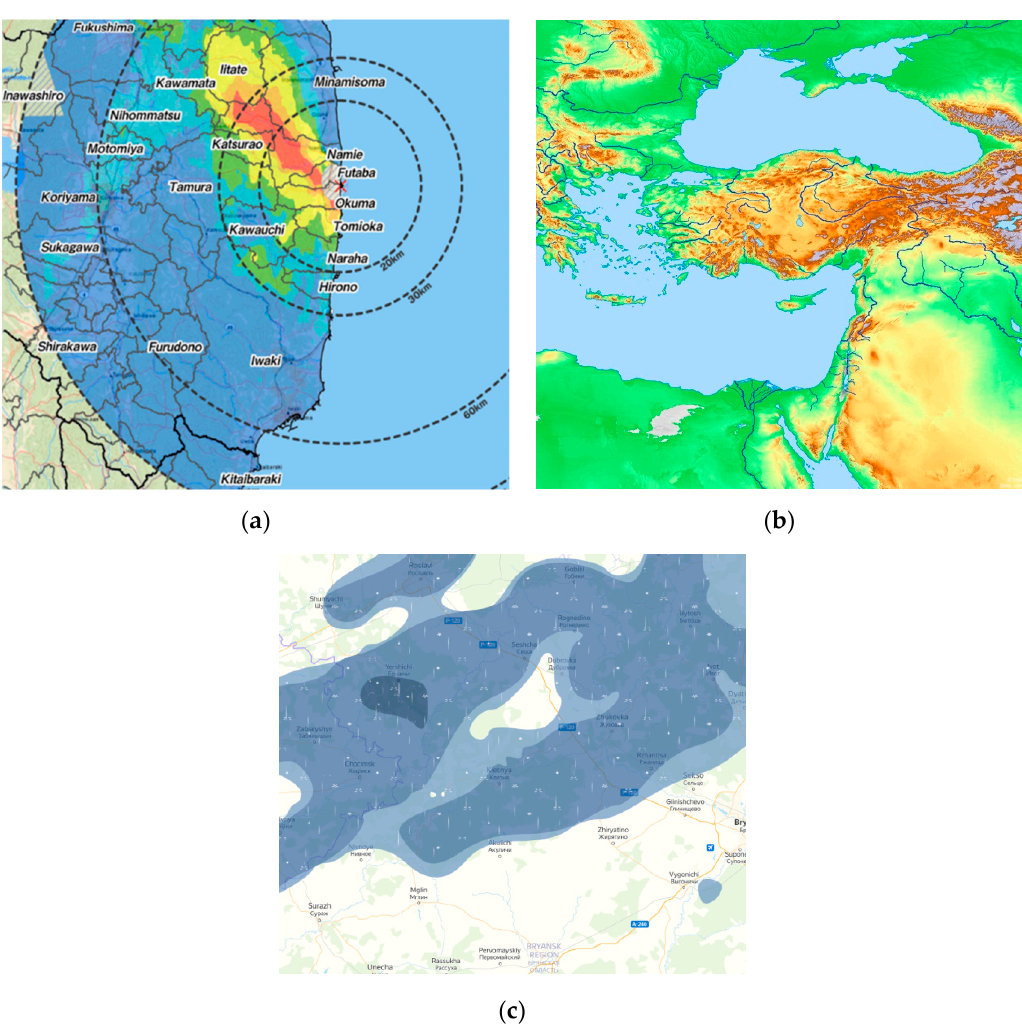
Figure 1. Appearance of maps of the area: ( a ) the density of chemical pollution; ( b ) altitude above sea level; ( c ) precipitation zones.